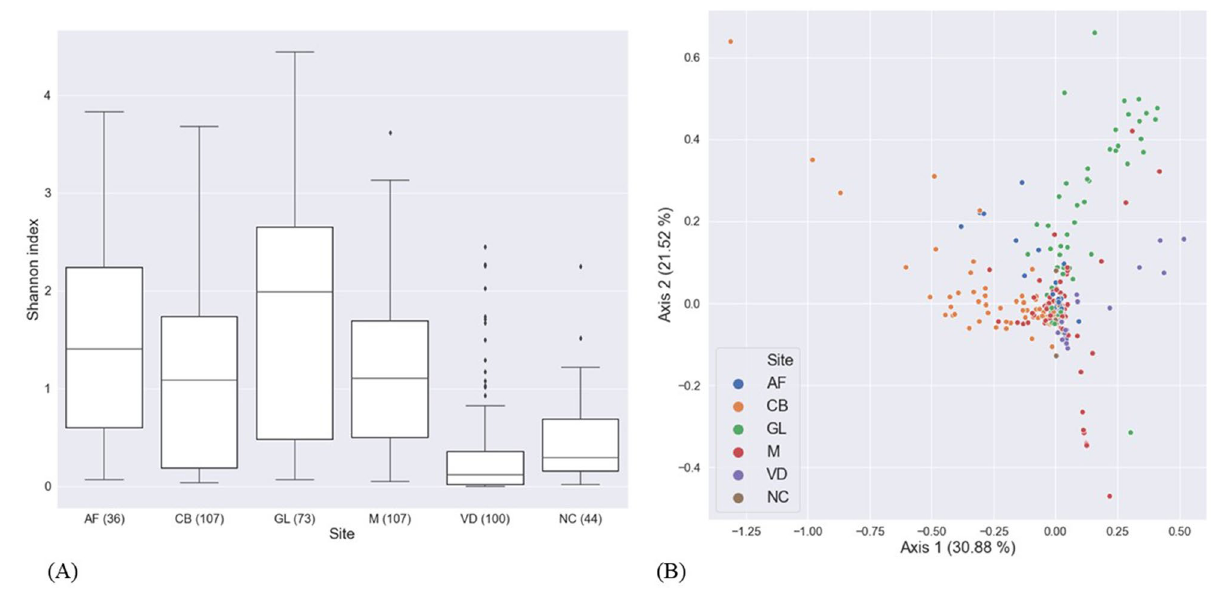
Figure 2. Alpha and beta diversity of the Korean maternal and neonatal microbiome. ( A ) Alpha diversity: The filtered ASV table was rarefied before Shannon index was computed for each sample. The VD group exhibited the least amount of alpha diversity. AF, amniotic fluid; CB, umbilical cord blood; GL, gastric liquid; M, meconium; VD, cervicovaginal discharge; NC, negative control; ( B ) Beta diversity: The filtered ASV table was rarefied before the samples were projected into 2D-space with principal coordinates analysis using the weighted UniFrac distance.